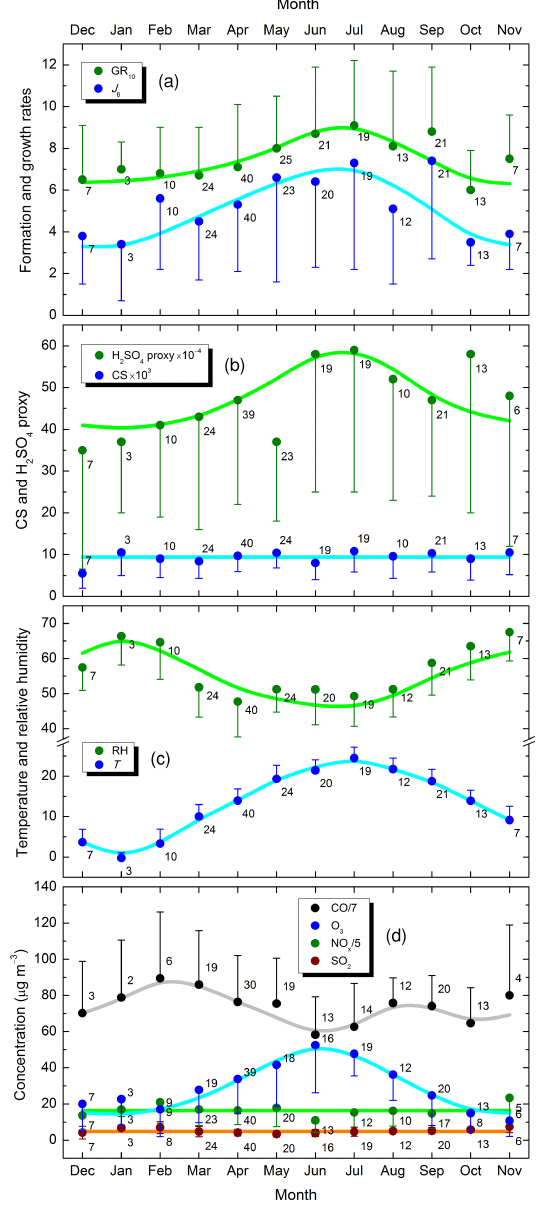
Figure 2. Distribution of monthly mean aerosol particle formation rate J 6 in units of cm − 3 s − 1 and particle diameter growth rate GR 10 in units of nmh − 1 (a) , mean condensation sink for vapours (CS) in units of s − 1 averaged over the nucleation time interval ( t 1 , t 2 ) and daily maximum gas-phase H 2 SO 4 proxy in units of µgm − 5 Ws (b) , daily mean air temperature ( T ) in units of ◦ C and daily mean rel- ative humidity (RH) in % (c) and daily median concentrations of SO 2 , O 3 , NO x and CO for quantifiable NPF and growth events in the city centre for the joint 5-year-long time interval. The error bars are shown for one side and indicate 1 standard deviation. The num- ber of individual data averaged in each month is displayed next to the symbols. The horizontal lines indicate the overall mean. The non-linear curves assist to guide the